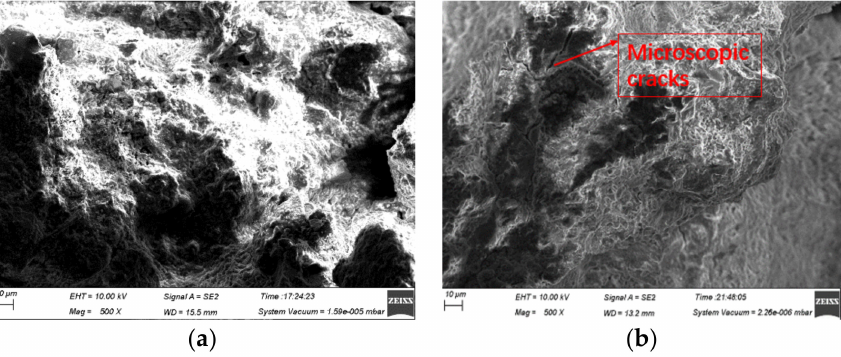
Figure 8. Comparison of SEM images before and after high-energy gas fracturing test. ( a ) Before high-energy gas fracturing test; ( b ) After high-energy gas fracturing